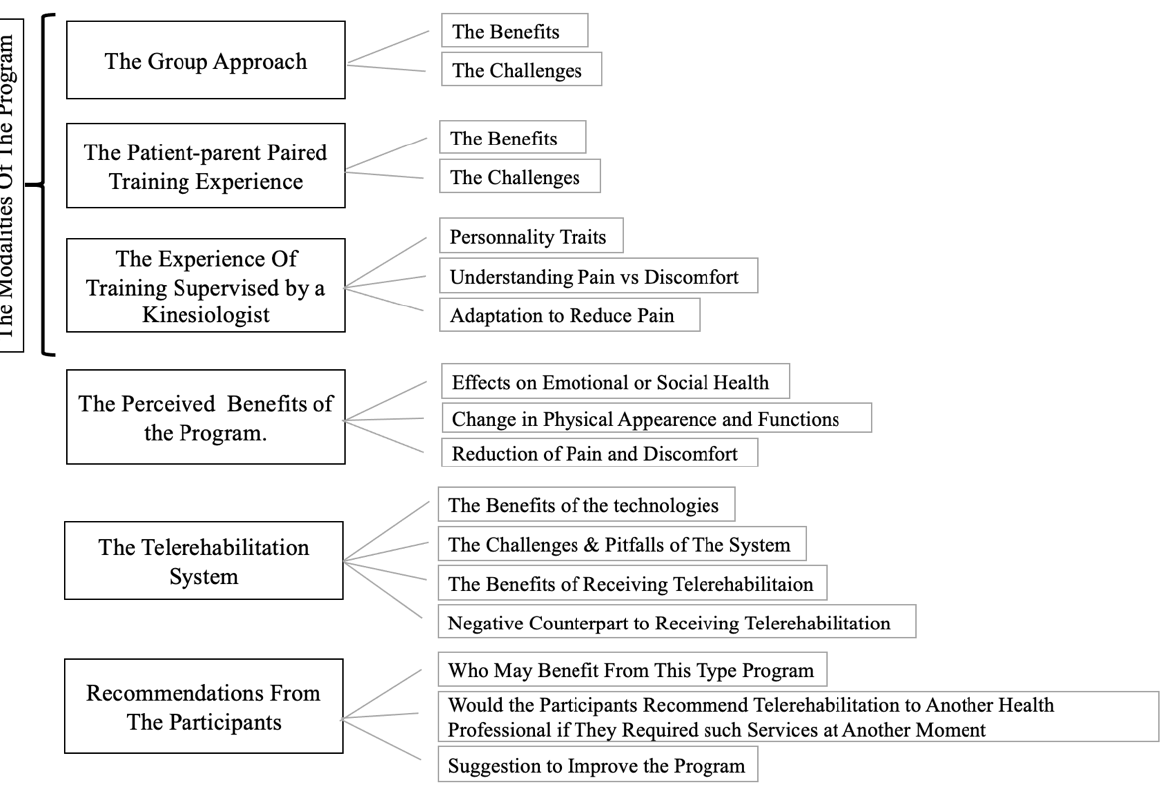
Figure 2. Overarching themes.